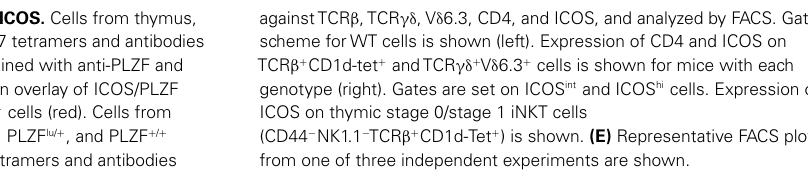
FIGURE 4 | PLZF regulates the expression of ICOS. Cells from thymus, spleen and liver were stained with CD1d-PBS-57 tetramers and antibodies against ICOS and CD4, fixed, permeabilized, stained with anti-PLZF and analyzed by FACS (A) . Results are depicted as an overlay of ICOS/PLZF plots for CD4 + CD1d − Tet − (green) and CD1d-Tet + cells (red). Cells from thymi (B) , spleens (C) , and livers (D) of PLZF lu/lu , PLZF lu/ + , and PLZF + / + mice were stained with PBS-57-loaded CD1d tetramers and antibodies